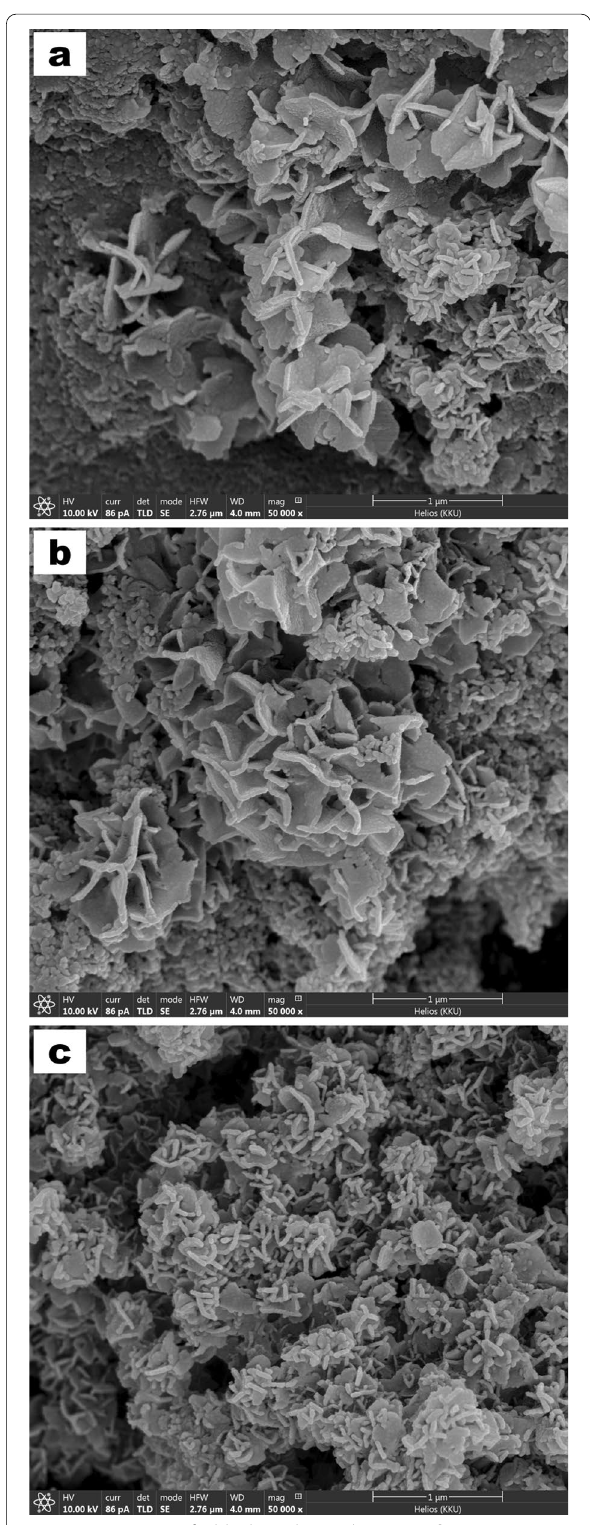
Fig. 7 SEM images of a blank synthesized Mg(OH) 2 , b Mg(OH) 2 -SDBS, and c Mg(OH) 2 -SDBS in the presence of fungicides (100 μg/L